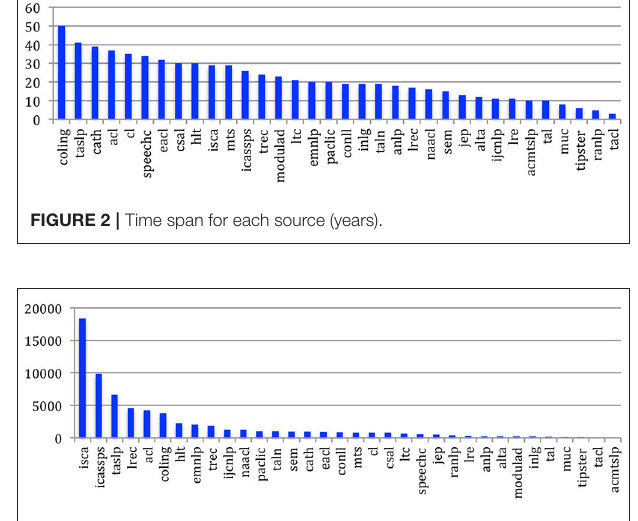
TABLE 2 | Sources attached to each of the three research areas.